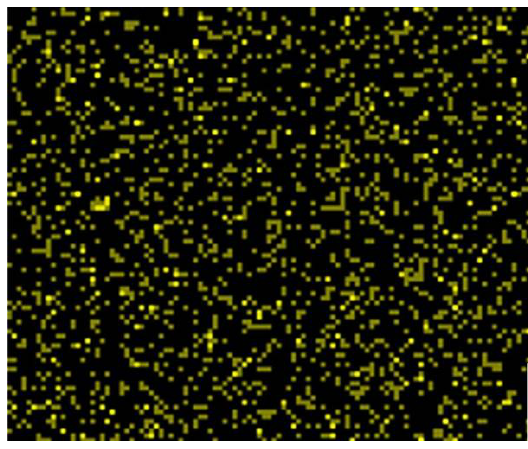
Figure 4. Metal mapping of the synthesized Er 3+ /TiO 2 NPs.